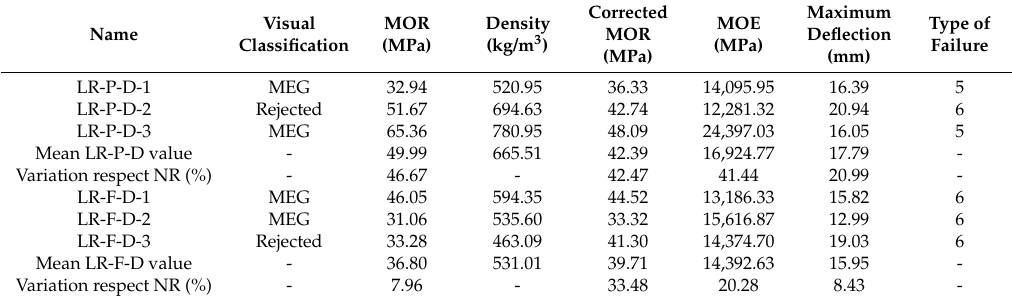
Mechanical results obtained from bending tests for LR-P-D and LR-F-D beams. Visual classification, MOR, density, density-corrected MOR, MOE, maximum deflection and type of failure. CFRP supplier: DRIZORO ® .